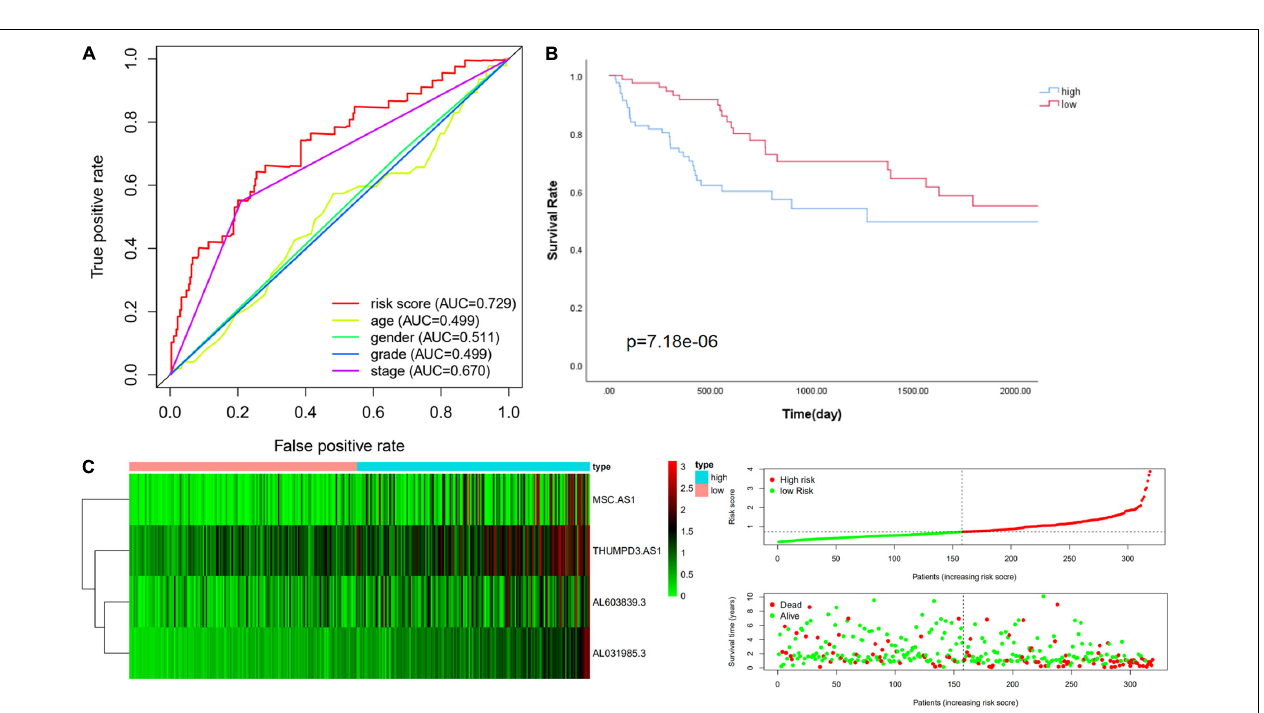
FIGURE 3 | Performance evaluation of the four immune LncRNA for survival prediction in the whole cohort. (A) ROC curve for 5 years of OS. (B) Kaplan–Meier survival curve for high-risk and low-risk groups divided by the median. (C) Heatmaps, distribution of risk scores with survival, and statuses of patients depend on selected immune LncRNA